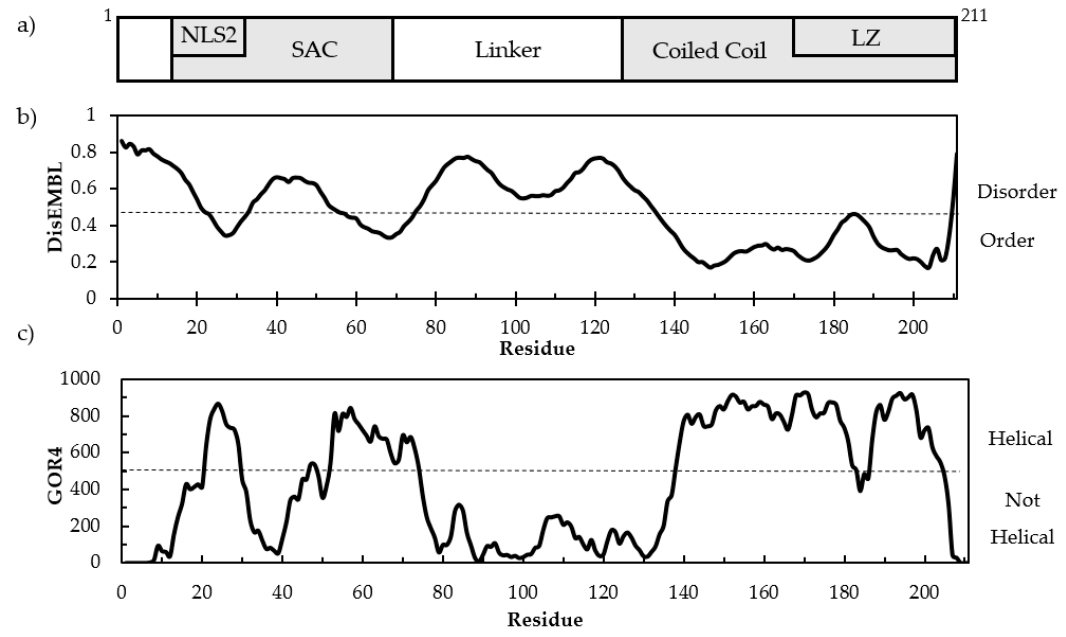
Figure 1. ( a ) Block diagram of caspase-3-cleaved Par-4 (cl-Par-4) domain structure. ( b ) DisEMBL disorder prediction. ( c ) GOR4 (Garnier-Osguthorpe-Robson) alpha helix prediction.